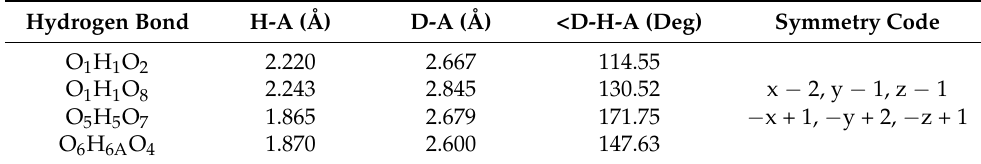
Table 2. Hydrogen-Bonding Distances and Angles for the